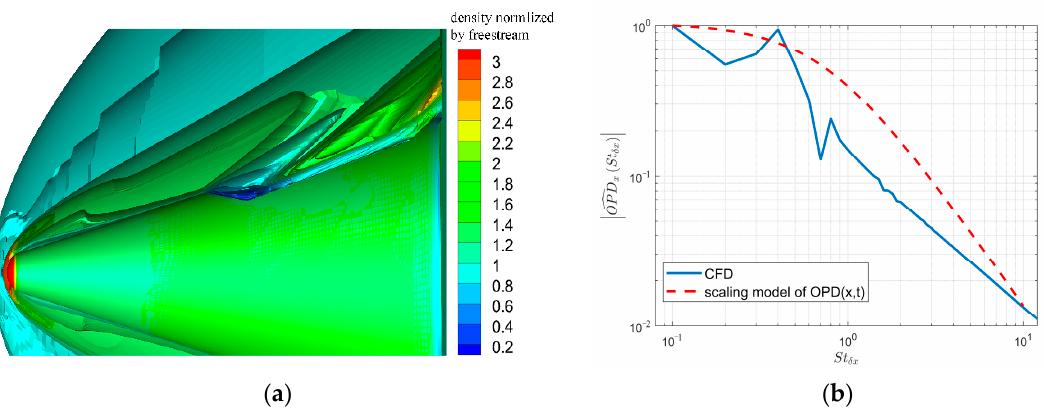
Figure 13. Simulation result with CFD mesh: ( a ) Isosurface of density field; ( b ) amplitude spectra of OPD.